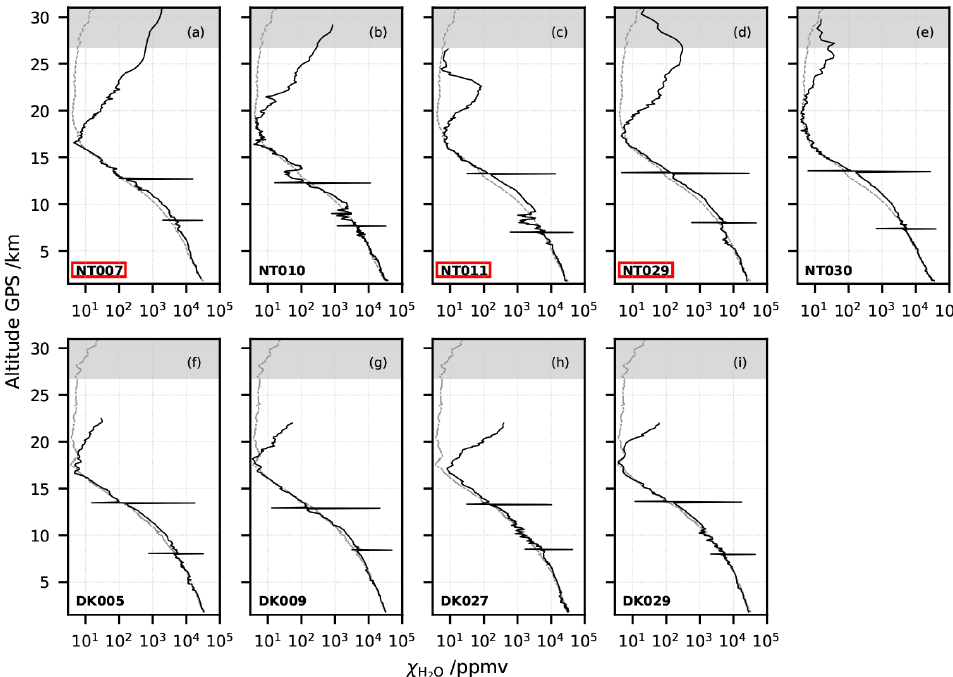
Figure 1. Nine water vapour mixing ratio profiles from the CFH showing contaminated values in the stratosphere (out of 43 profiles taken during StratoClim 16/17). (a–e) Campaign in Naintal (NT), India, summer 2016. (f–i) Campaign in Dhulikhel (DK), Nepal, summer 2017. Black lines: measured individual profiles. Grey lines: respective campaign season average (mean of 22 (NT) or 7 (DK) profiles), excluding the individual profiles presented here as contaminated, as shown in Brunamonti et al. (2018). Grey shading highlights possible balloon contamination above the 20hPa level in the season average. Two spikes per profile: instrumental clearing and freezing cycles. Highlighted in red: three night-time launches with the CFH and the COBALD, which are further investigated in this study.